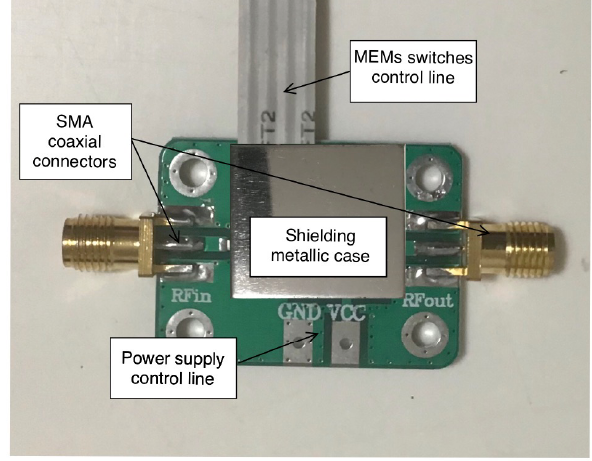
Figure 13. Photo of the reconfigurable interdigitated pseudohairpin filter prototype.